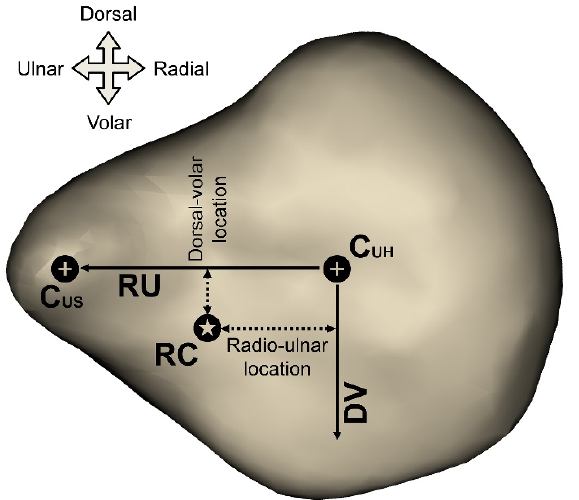
Figure 2. Measurement of the location of the RCs. The center of the distal radioulnar articular surface of the ulnar head (C UH ) and the center of the ulnar styloid process (C US ) using the least square circle fitting method. Line RU, a line passing through C UH and C US, was set as the reference for the direction of the radioulnar measurement. Line DV, a line passing through C UH and perpendicular to line RU, was set as the reference for the direction of the dorsal–volar measurement. The radioulnar location of the RC was measured as the distance between line DV and the RC. The dorsal–volar location of the RC was measured as the distance between line RU and the RC.